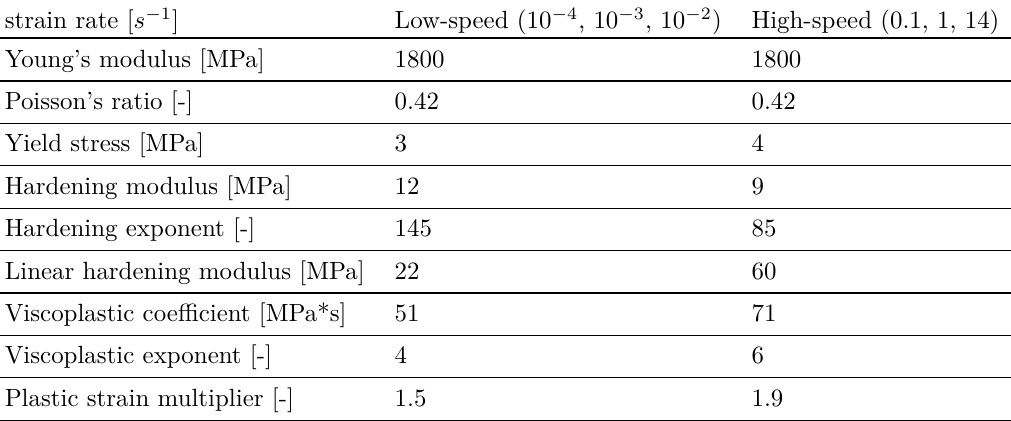
Table 2. Reverse engineered elastic-viscoplastic material parameters for low-speed and high-speed strain rates.